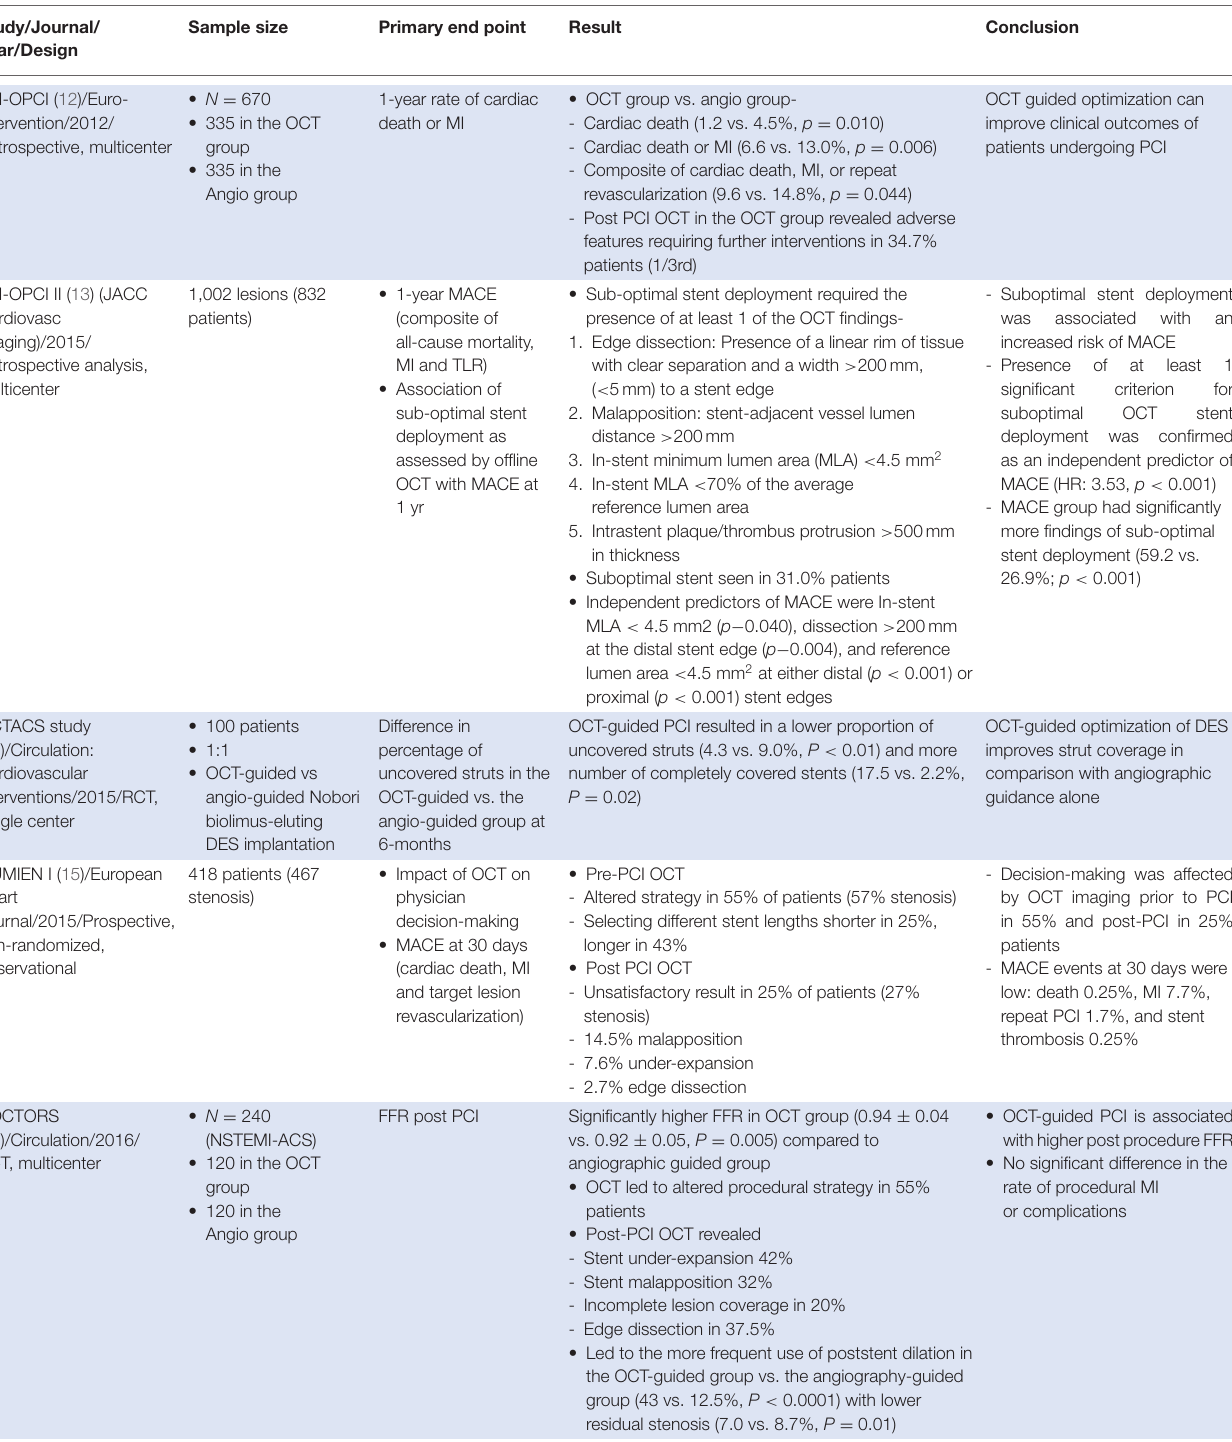
TABLE 2 | Studies performed for a comparison between OCT and angiography for percutaneous coronary intervention (PCI)